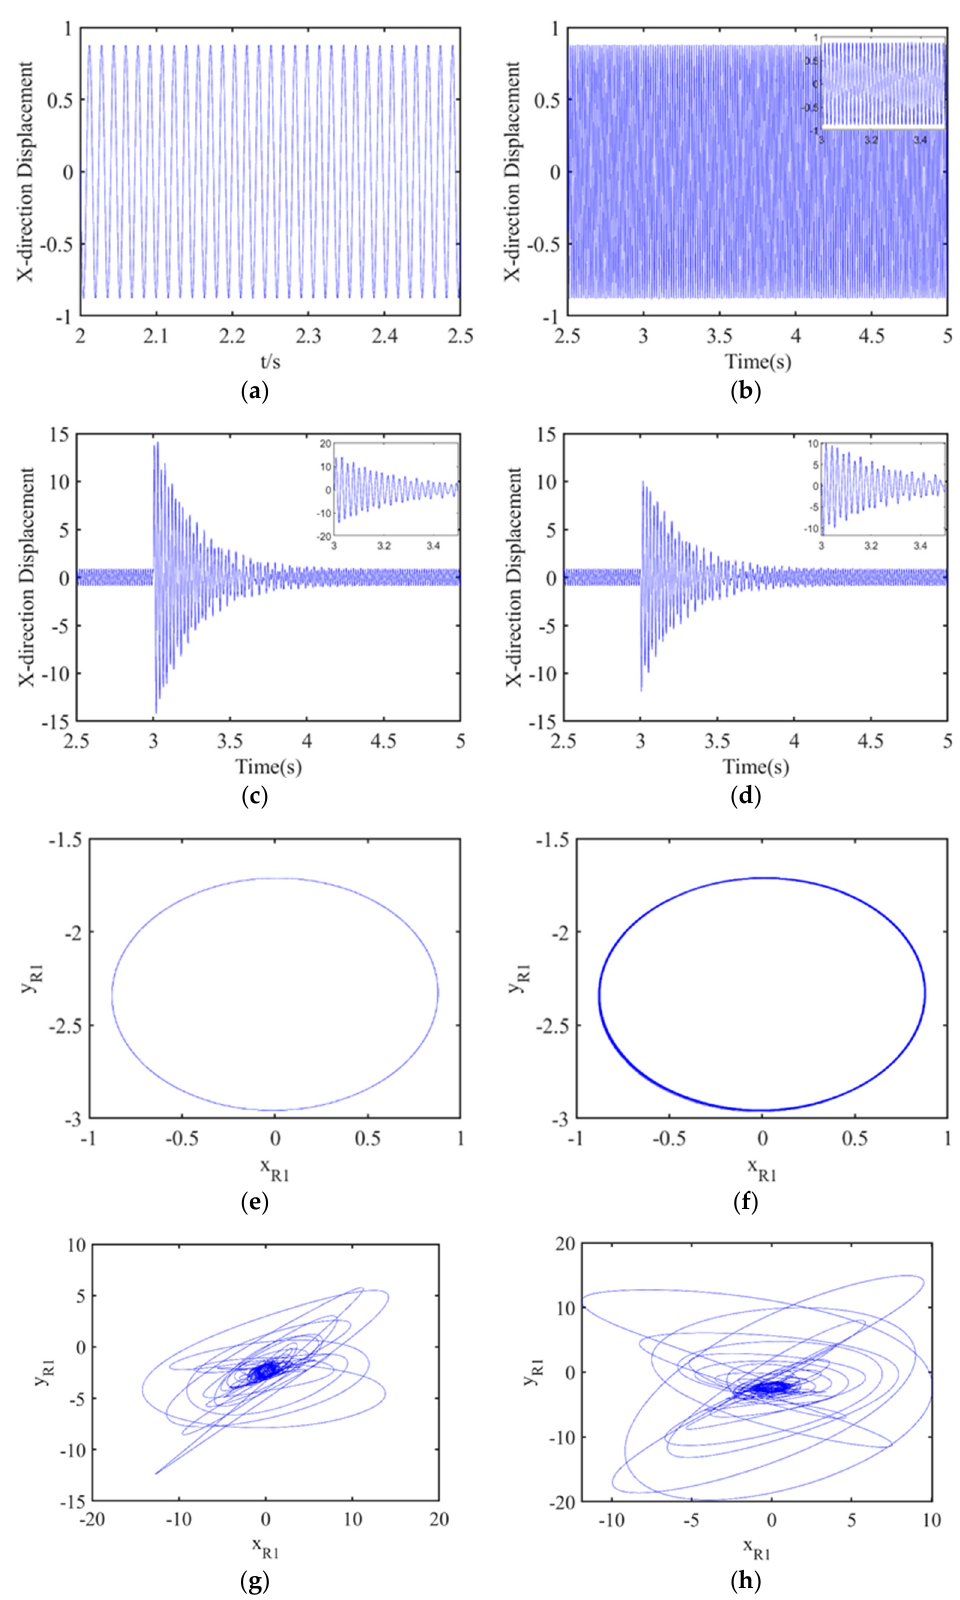
Figure 10. The dynamic response of the fan before and after bird strike: displacement vs. time in the X direction ( a ) before bird strike; ( b ) after small flocking bird strike; ( c ) after medium flocking bird strike; ( d ) after large single bird strike; axis orbit: ( e ) before bird strike; ( f ) after small flocking bird strike; ( g ) after medium flocking bird strike; ( h ) after large single bird strike.